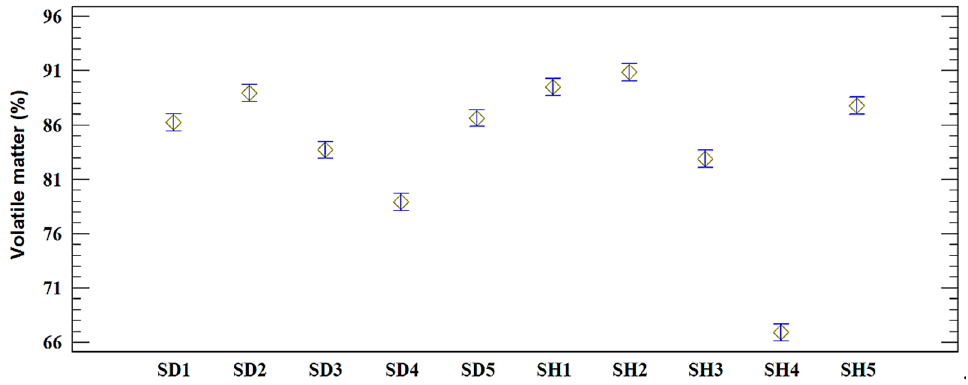
Figure 6. Volatile matter for the sawdust (SD) and shavings (SH) samples (%). In relation to fixed carbon (Figure 7), the analysis of variance indicates that there are statistically significant differences ( p = 0.0000).